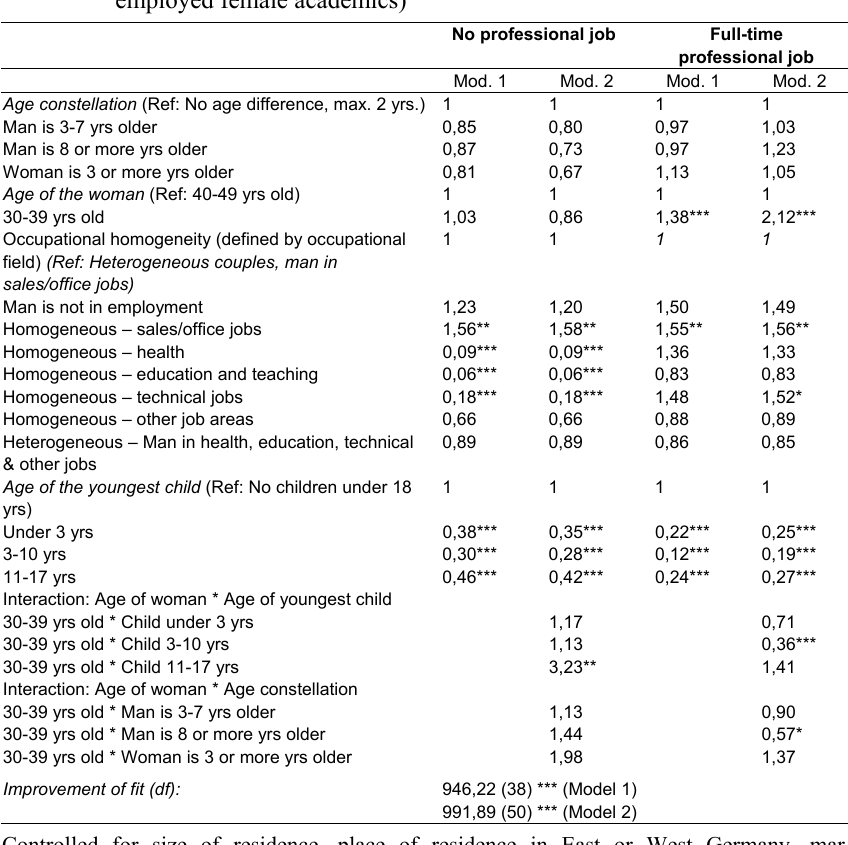
Table 6: Multinomial logistic regressions on the chance of being employed in a professional job by female academics in academic couples (reference category: Part-time professional job) (odds ratios, N = 3,538 only employed female academics) No professional